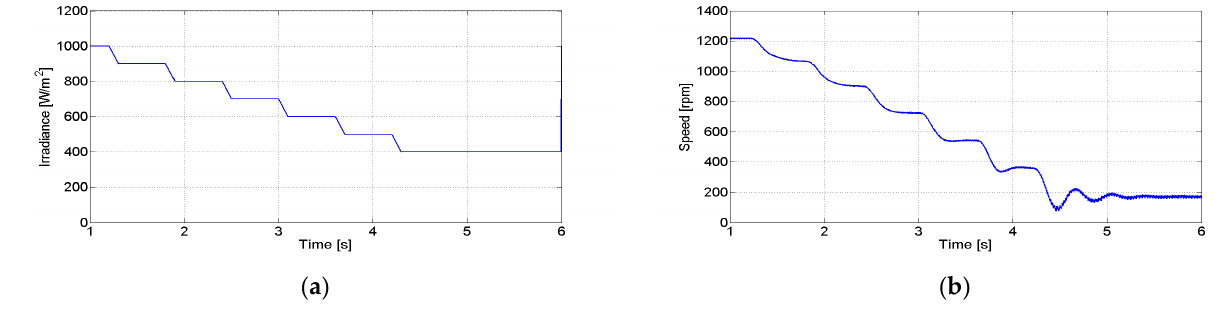
( b ) ( c ) Figure 9. Obtained simulation waveforms during the connection of the system: ( a ) solar irradiation applied to the PV panels, ( b ) SRM motor speed, ( c ) DC/DC output voltages. Tests with respect to various irradiances applied to the PV panel were also carried out. Thus, in order to see the impact of these changes in the system, in Figure 10, the obtained waveforms when the irradiance changes from 1000 W/m 2 to 400 W/m 2 in steps of 200 W/m 2 are presented. In Figure 10a, the irradiance applied to the PV panel is presented,